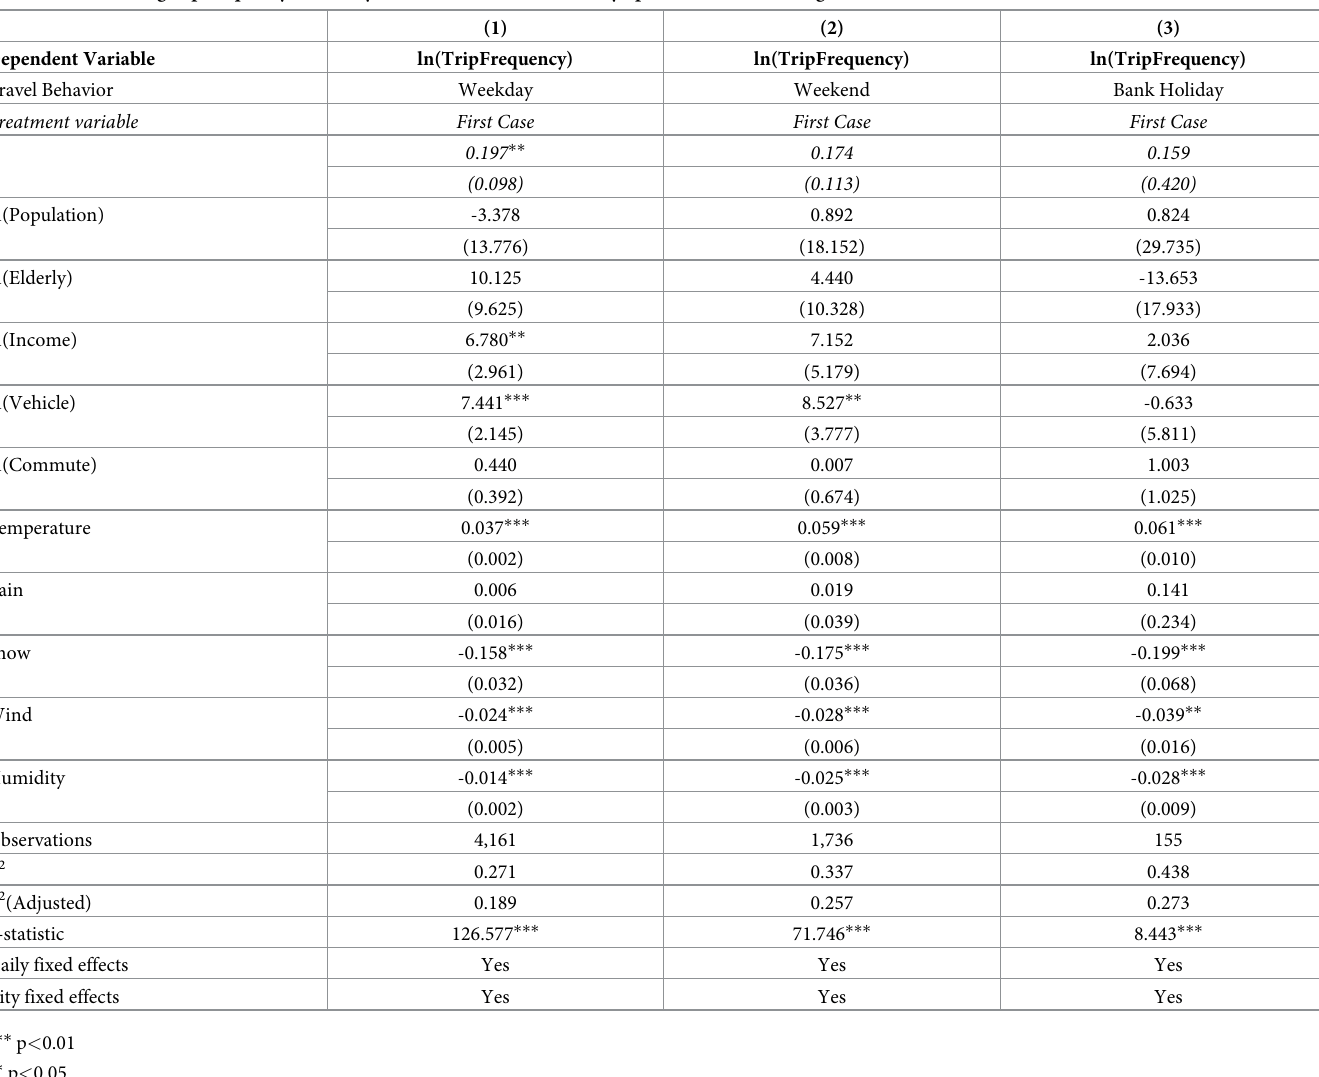
Table 5. Bike-sharing trip frequency: Weekday-, weekend-, and bank holiday-specific fixed-effects regression results where the treatment is the first Covid-19